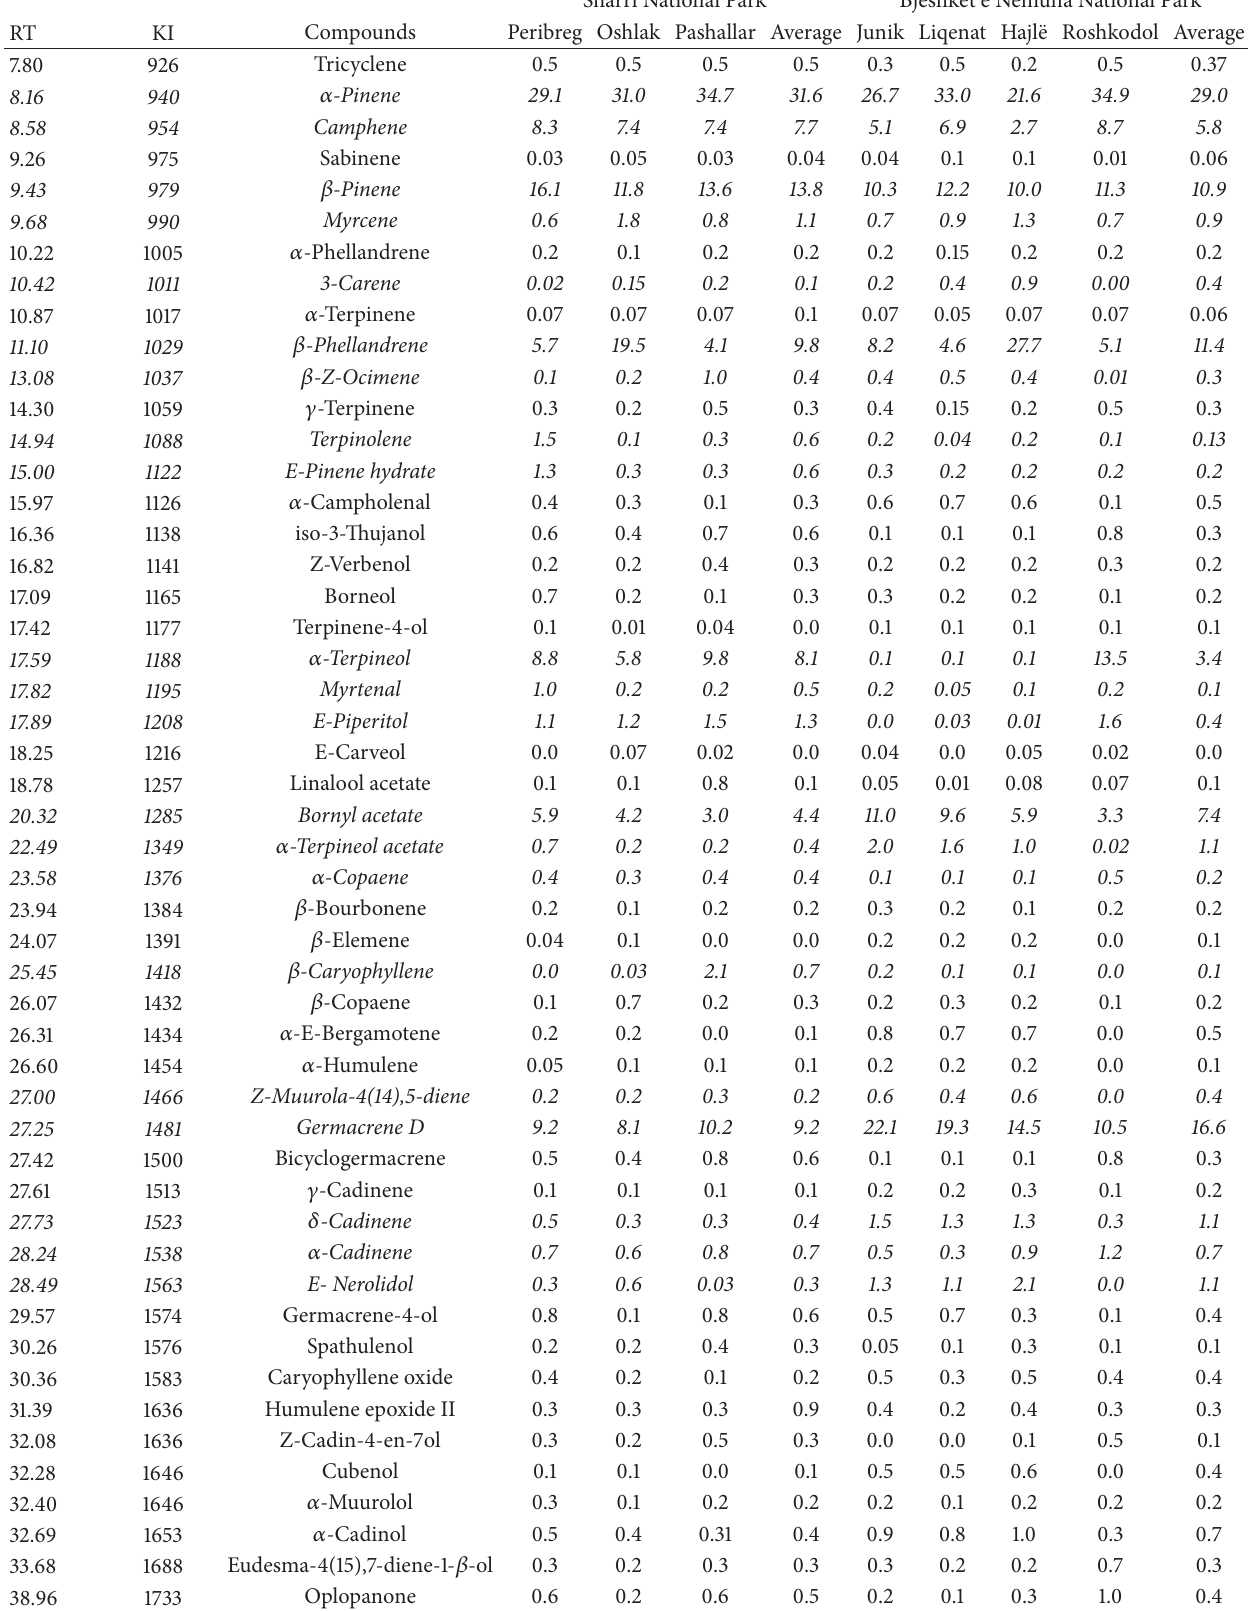
Table 2: Composition (%) of the needles oils of Pinus peuce from different